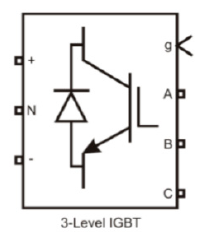
Figure 11. Three-level insulated-gate bipolar transistor (IGBT) block in Simulink.